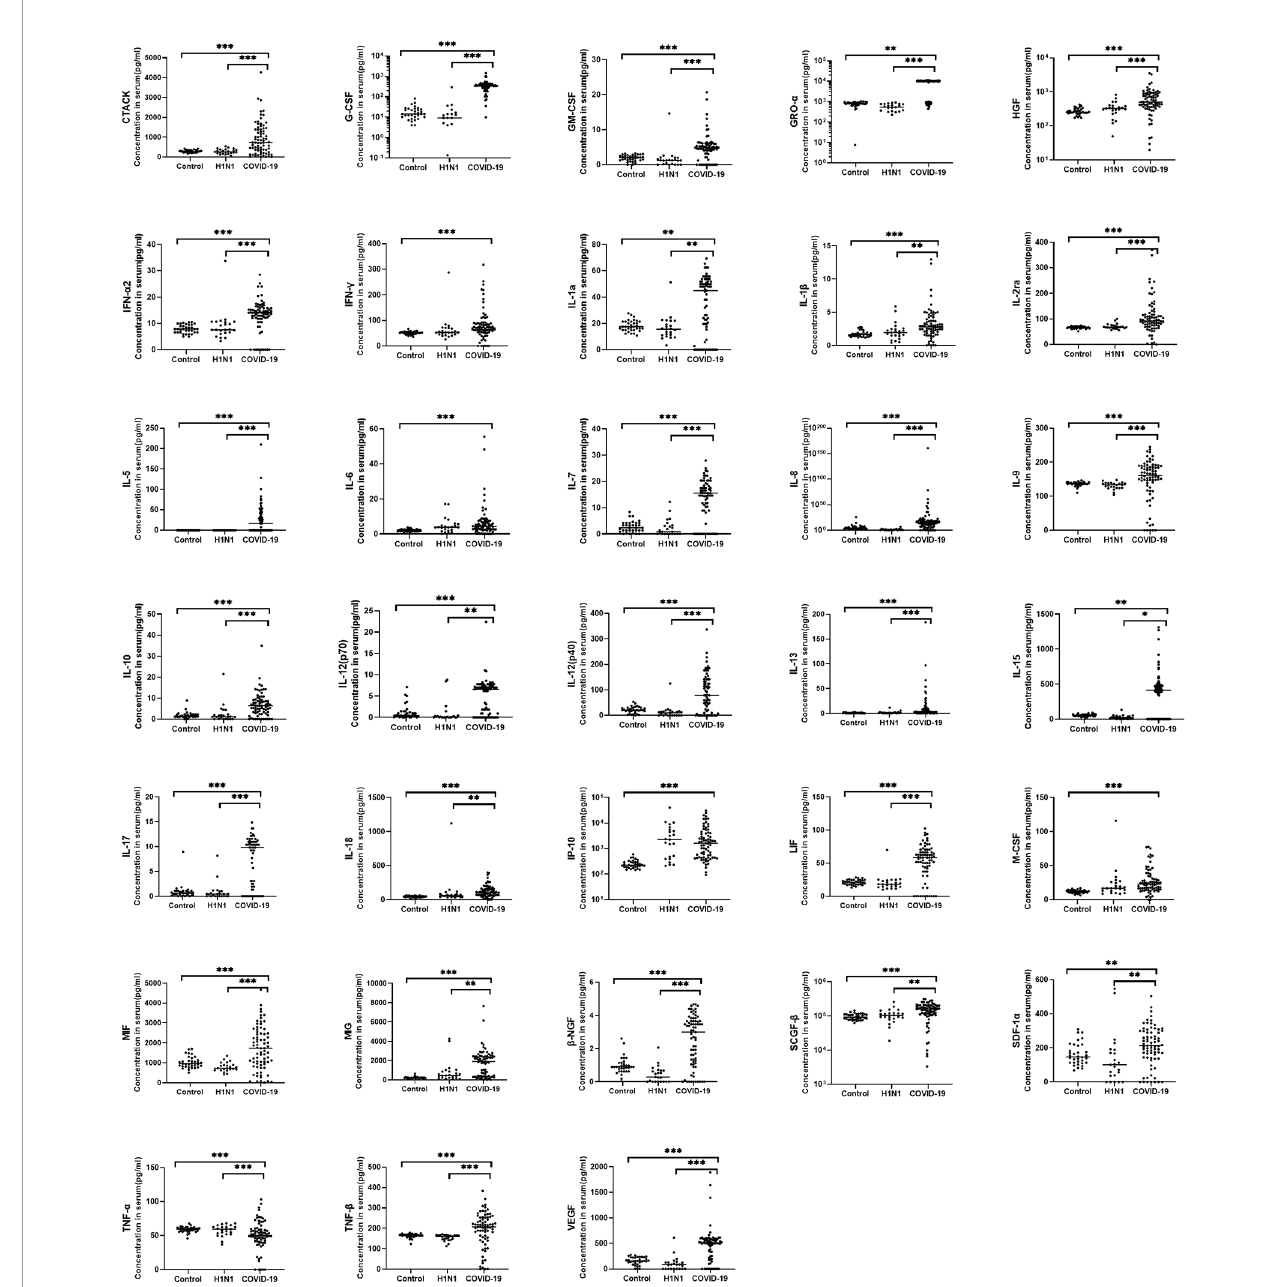
FIGURE 1 | Comparison of serum cytokine concentrations between COVID-19 patients, H1N1 patients and healthy controls. Serum from COVID-19 patients (N=75), H1N1 patients (N=23) and healthy controls (N=34) were collected and 48 kinds of cytokines were measured. The horizontal line represents the median. Of the cytokine examined, 33 cytokines were signi fi cantly increased in COVID-19 patients when compared with the healthy controls, 29 cytokines were signi fi cantly increased in the COVID-19 group compare with H1N1 group. *P < 0.05, **P < 0.01, ***P <